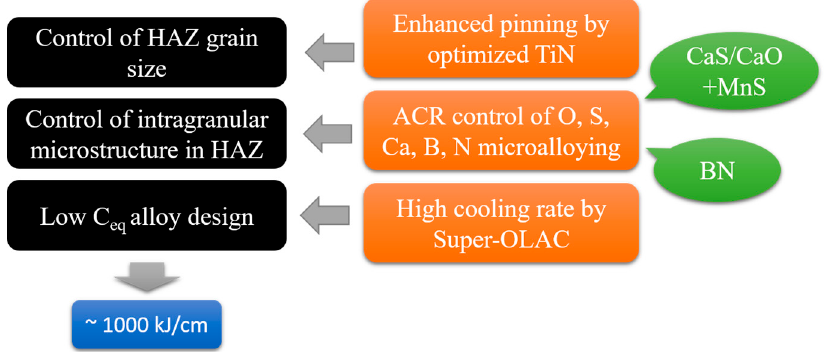
Figure 2. Characteristics of JFE EWEL [26]. OLAC: online accelerated cooling; ACR: atomic concentration ratio.